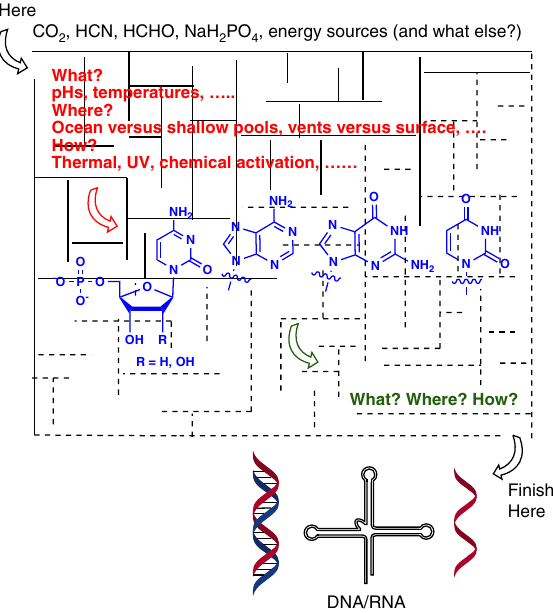
Fig. 1 Exploring the maze of conditions leading to formation of nucleotides and eventually to DNA/RNA. The end-goal of getting DNA and RNA from a given set of plausible starting materials should seem straightforward but is complicated by the labyrinth of prebiotically plausible conditions and environments on early